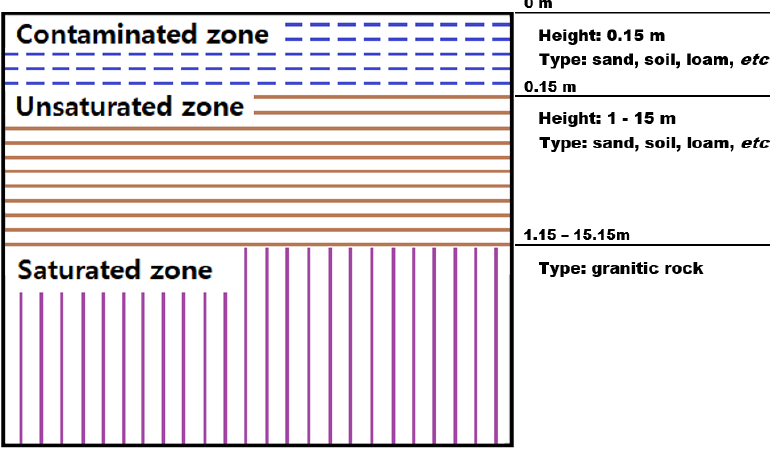
Figure 1. Geological structure model of the Wolsong NPP site.